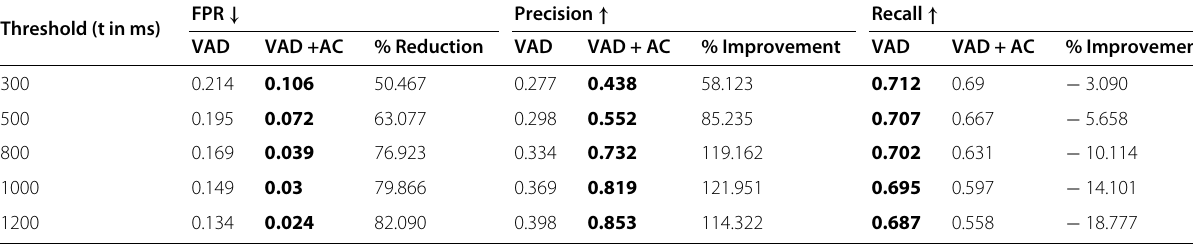
Table 6 Block-level analysis on human annotated dataset. ↓ : lower is better and ↑ : higher is better Threshold (t in